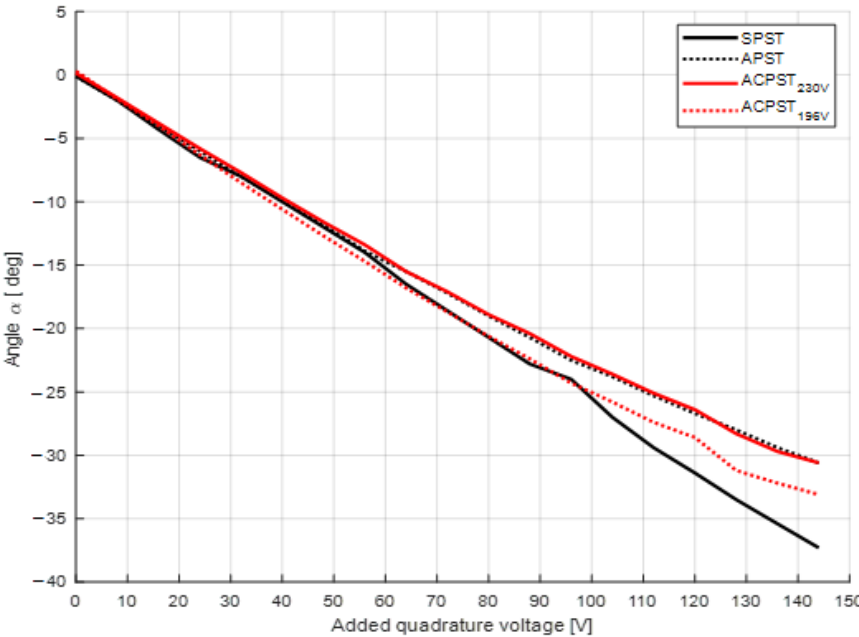
Figure 15. Angle α versus injected quadrature voltage for SPST, APST, and both ACPST cases. The ACPST 230 V case and APST have very similar courses. The ACPST 196 V